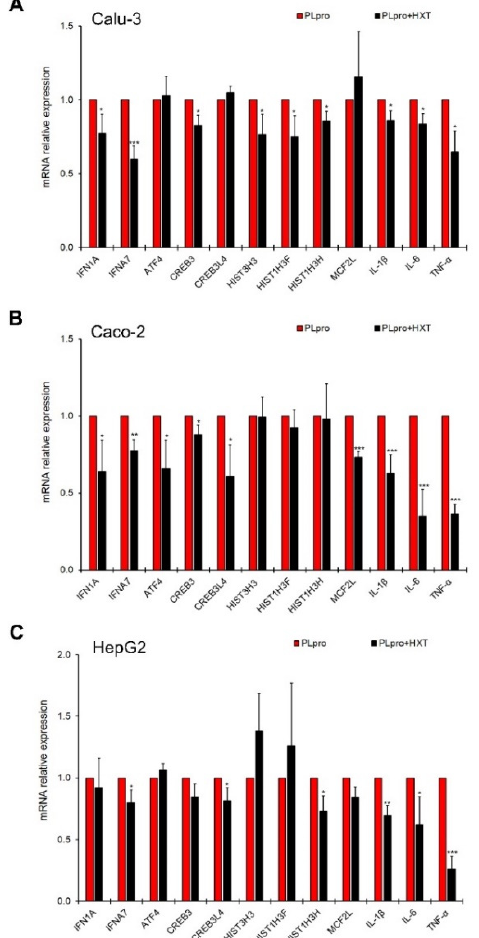
Figure 3. Treatment with HXT down-regulates pro-inflammatory genes in epithelial cells. Relative mRNA expression of IFNA1, IFNA7, ATF4, CREB3, CREB3L4, HIST3H3, HIST1H3F, HIST1H3H, MCF2L, IL-1 β , IL-6 and TNF- α genes measured by qRT-PCR in Calu-3 ( A ), Caco-2 ( B ), and HepG2 ( C ) cells expressing PLpro before and after treatment with 10 µ M HXT for 24 h. Values represented mean ± SD of two independent experiments repeated at least in duplicate. Data were analyzed by 2-tailed t -tests, * p < 0.05, ** p < 0.01, *** p < 0.001 vs. PLpro.